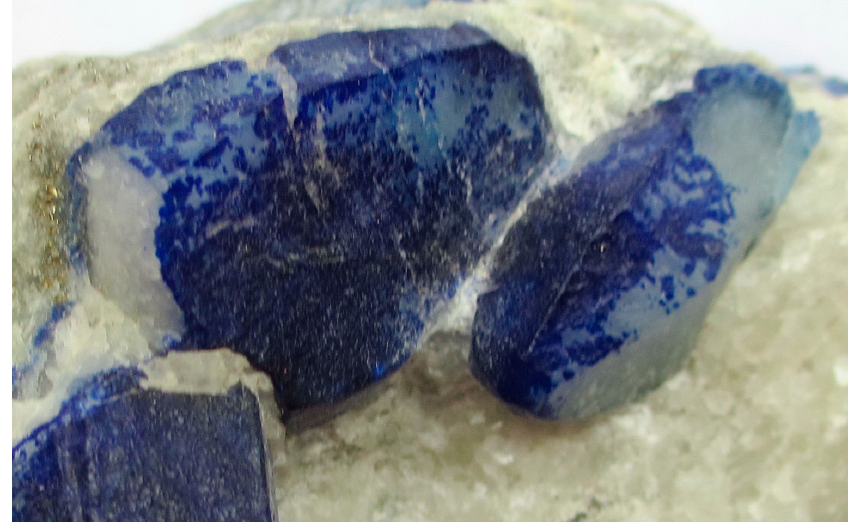
Figure 18. Epitaxy of S 3 •− -rich and SO 42 − -depleted lazurite (deep blue) on afghanite crystals. Field of view width: 3.5 cm. The sample originates from the Sar-e Sang gem lazurite deposit, Badakhshan, Afghanistan. Photographer: Nikita V. Chukanov.